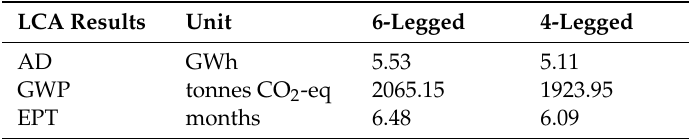
Table 6. Summary of